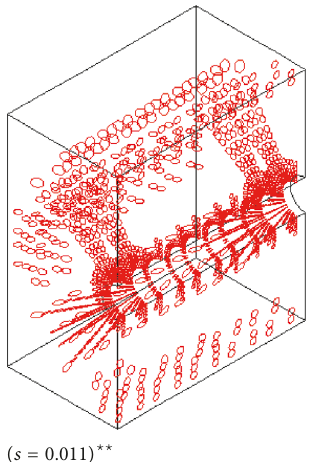
Figure 11: Displacement resulting from corrosion-induced expan- sion =